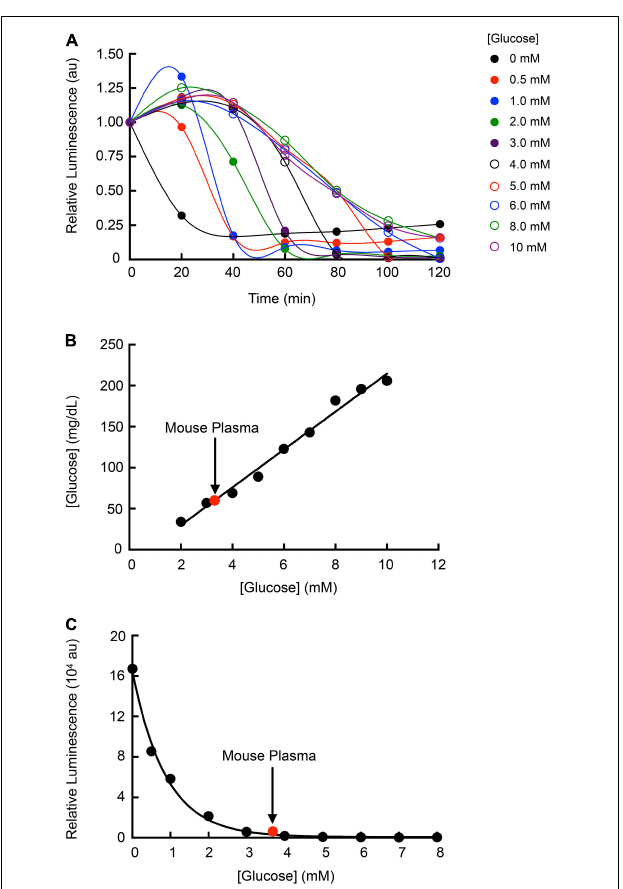
FIGURE 7 | Utilizing Strep. Xen20 bioluminescence production to estimate plasma glucose concentrations. (A) Strep. Xen20 cells in the stationary phase were added to equal volumes of PBS with 0–10 mM glucose. The luminescence was measured with a luminometer every 20 min for 2 h. Curves through the points are connected via a cubic spline, and no parameters were obtained. (B) The glucose levels (mg/dl) of each PBS and glucose solution were measured using a commercially available blood glucose meter. Mouse plasma (indicated on graph in red) was also tested for blood glucose levels, which were used to estimate millimolar concentration. (C) Final luminescence in the Strep. Xen20 sample in glucose between 0 and 8 mM after incubation overnight. The exponential relationship yielded an equation of y = 16,7000e × 0 . 882 x ( R 2 = 0.9861) and was used to estimate the mouse plasma glucose level based on luminescence of the Strep.